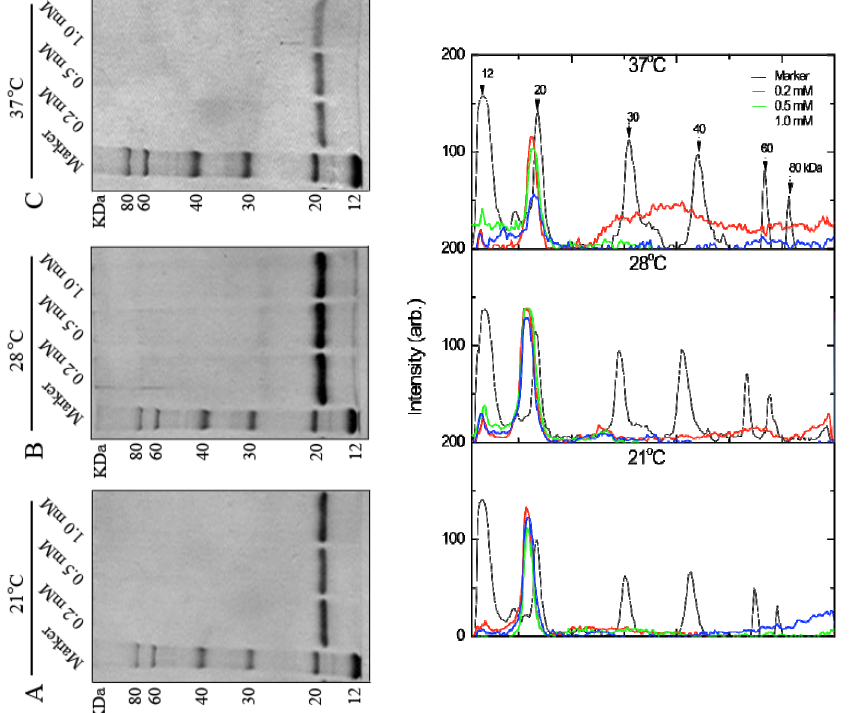
Figure 2. Effects of induction temperatures and IPTG concentrations on the soluble expression of His- FIP-fve at different temperatures: ( A ) 21 °C; ( B ) 28 °C; and ( C ) 37 °C with lane 1, molecular weight marker; lane 2, 0.2 mM IPTG; lane 3, 0.5 mM IPTG; lane 4, 1.0 mM IPTG. ( D ) Plots of ( A ), ( B ), and ( C ) after digitalization using Image J (NIH, USA). The different consecutive elution fractions were mixed and then were used for SDS-PAGE gel